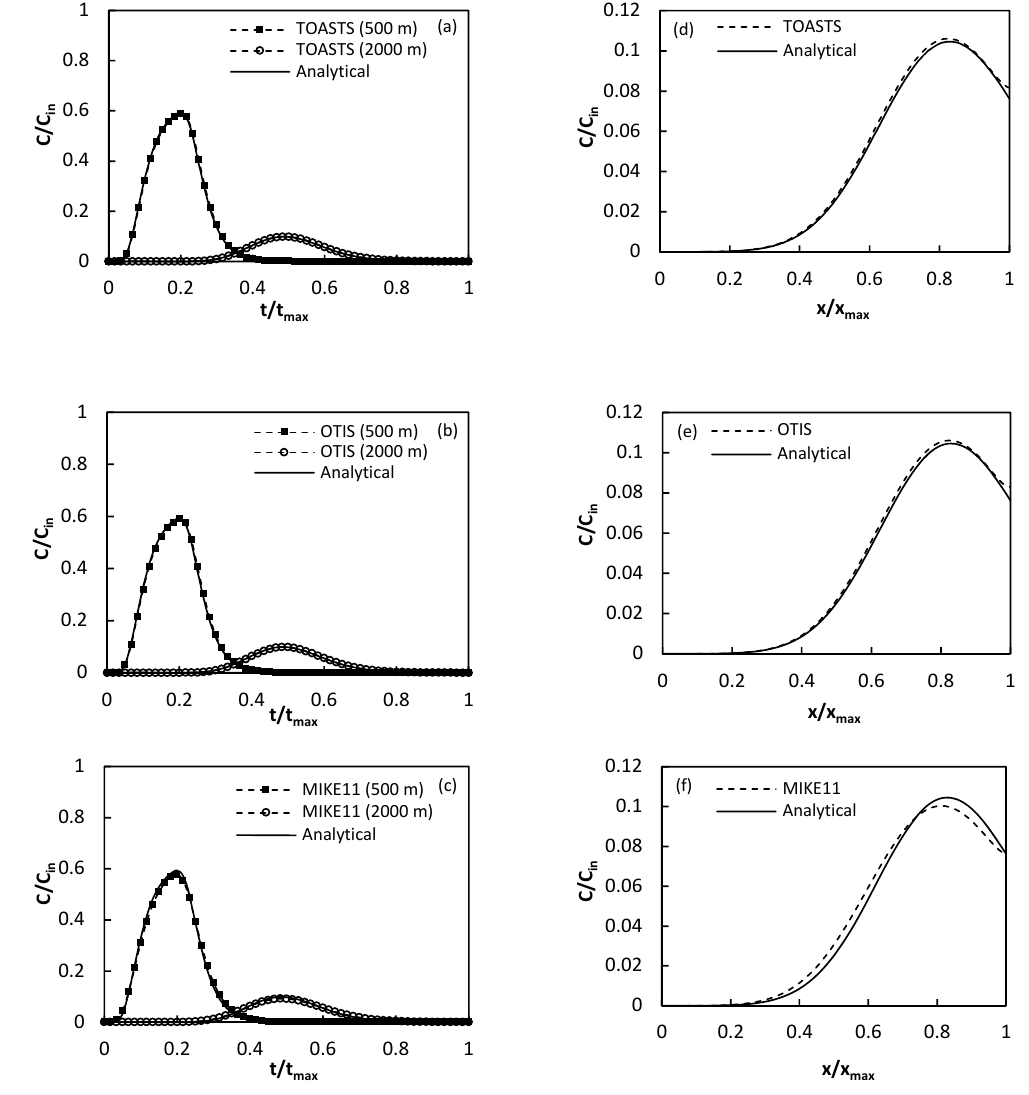
Figure 9. Comparison of the TOASTS, OTIS and MIKE 11 models in test case 2 for Pe = 0.24.